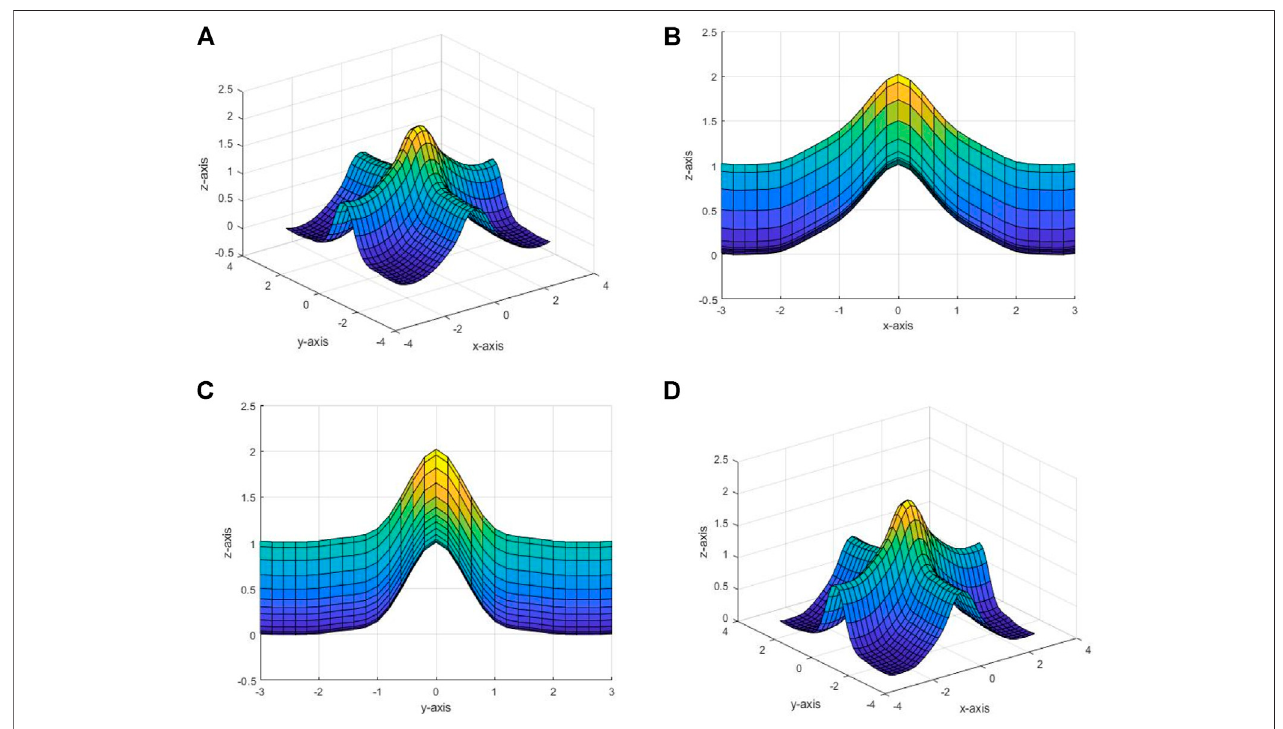
FIGURE 7 | Interpolating surface using the proposed scheme for Example 3. Interpolating surfaces for data in Table 5 . (A) Default surface. (B) xz-view for (A) . (C) yz-view for (A) . (D) The proposed scheme. (E) xz-view for (D) . (F) yz-view for (D) . (G) Other view for (A) . (H) Other view for (D) . (I) Karim et al. [36]. (J) Abbas et al. [1].